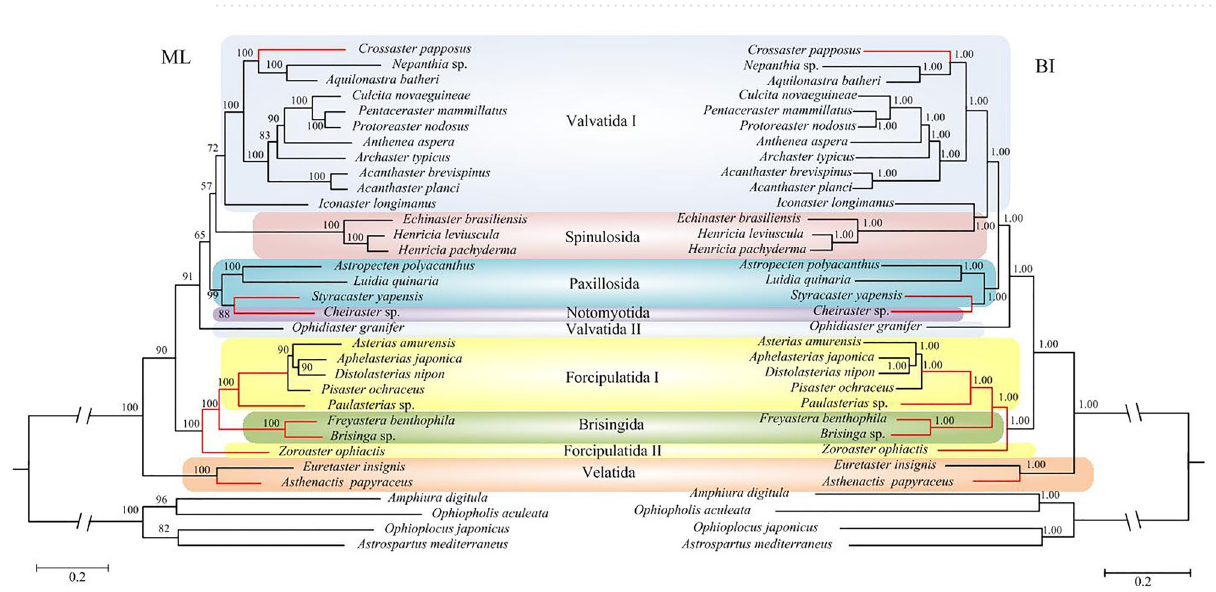
Figure 3. Phylogenetic analysis of ML and BI based on the amino acid sequencces of the 13 concatenated protein-coding genes. The bootstrap probability and the Bayesian posterior probability were shown at each node. The deep-sea branchs were marked by